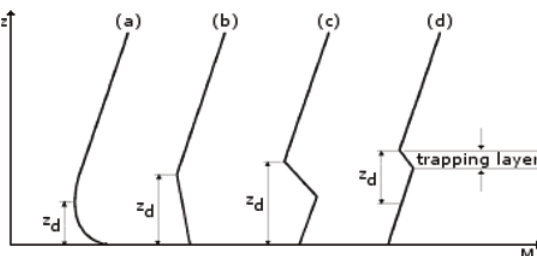
Figure 1. M ( z ) profiles for: (a) evaporation duct; (b) surface duct; (c) Fig. 1 M ( z ) profiles for: (a) evaporation duct; (b) surface duct; surface-based duct; (d) elevated duct; z d – duct thickness. (c) surface-based duct; (d) elevated duct; z d – duct thickness. The evaporation duct is practically always present over the ocean at lower latitudes, its thickness increases during the summer months and during the daytime [8, 22]. On a worldwide basis surface-based ducts are known to tween the top of the region of negative gradient (the trap- appear about 14 % of the time, in certain regions - up to 50 % of the time [22, 23]. As for Europe, the climatology summarized in von Engeln and Teixeira [22] and Lopez [24] shows high ducting probability mostly in the ping layer) and either the level at which M exceeds the Mediterranean region (see also Bech et al. [13]); some areas in the temperate zone are especially prone to anomalous value at the top of the trapping layer (in this case elevated propagation: the Black sea [25, 26], the British Channel, and East Anglia [27-29]. Even the northern parts of Europe duct is formed) or the Earth’s surface (surface-based